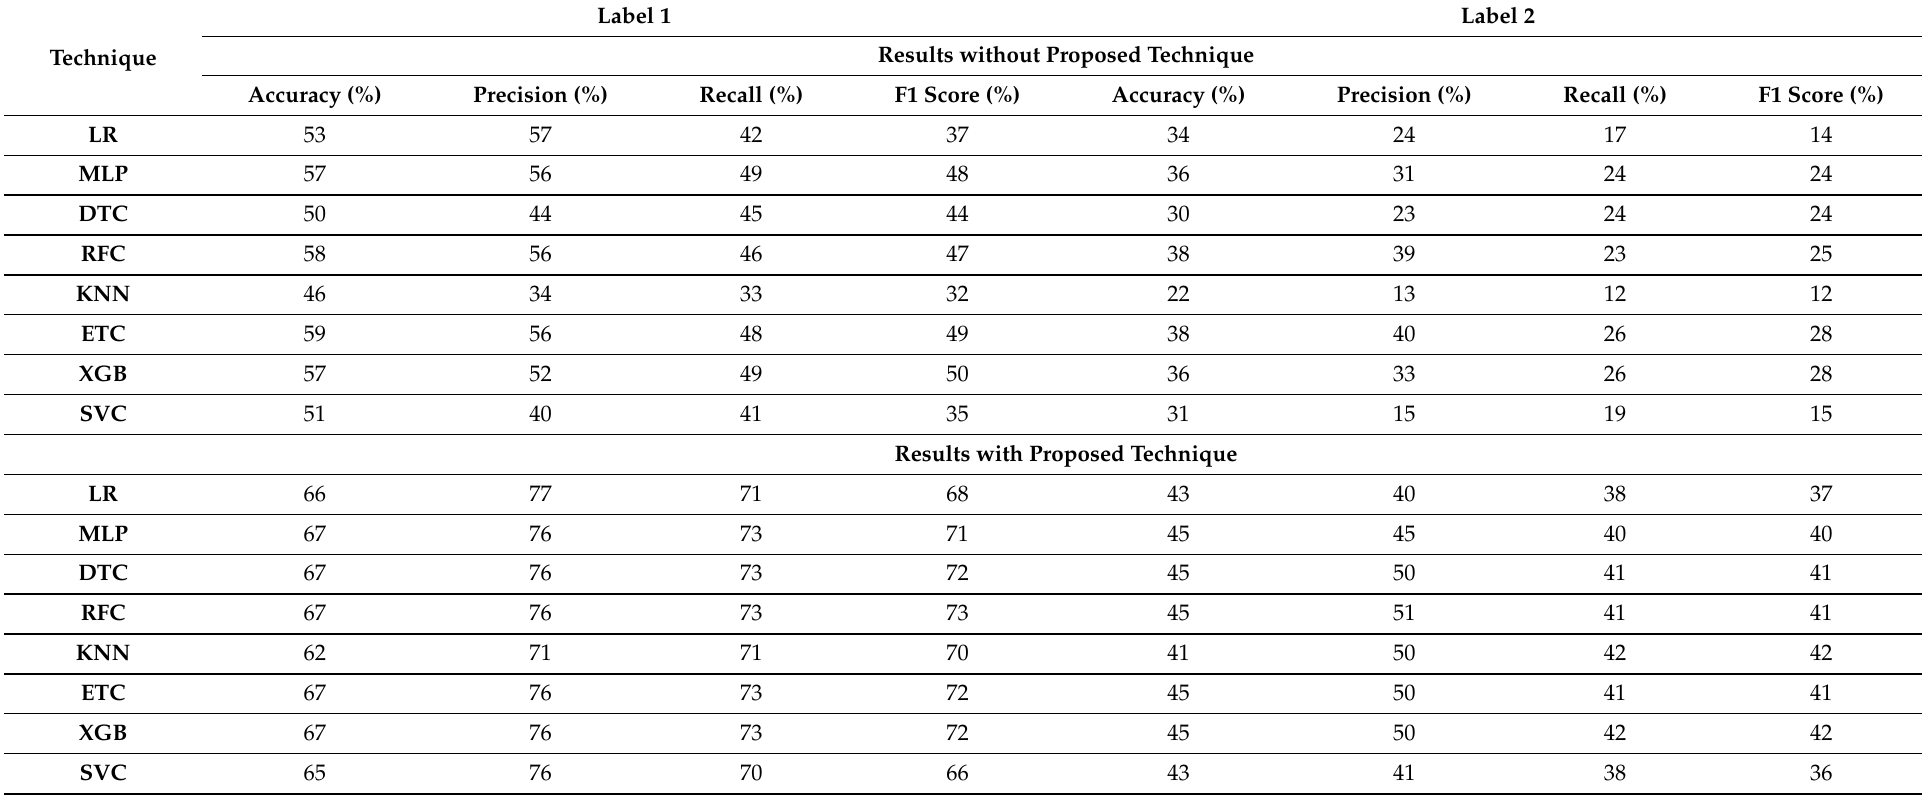
Table 10. Performance comparative analysis using an imbalanced dataset with a data split of